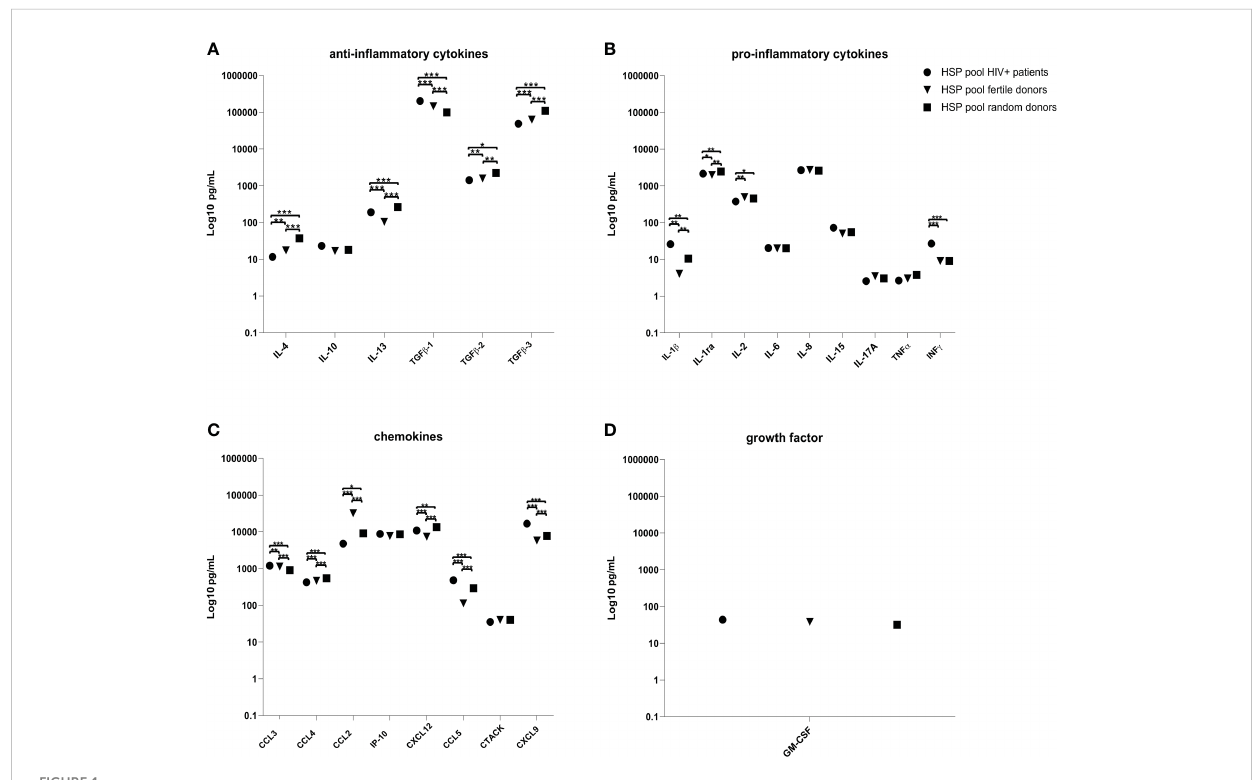
FIGURE 1 Cytokines, chemokines and GM-CSF quanti fi cation in HSP pools. Concentrations (pg/mL) of ant-in fl ammatory cytokines (A) , pro-in fl ammatory cytokines (B) , chemokines (C) and GM-CSF (D) in the three pools of HSP samples obtained from 12 HIV negative fertile, from 21 HIV